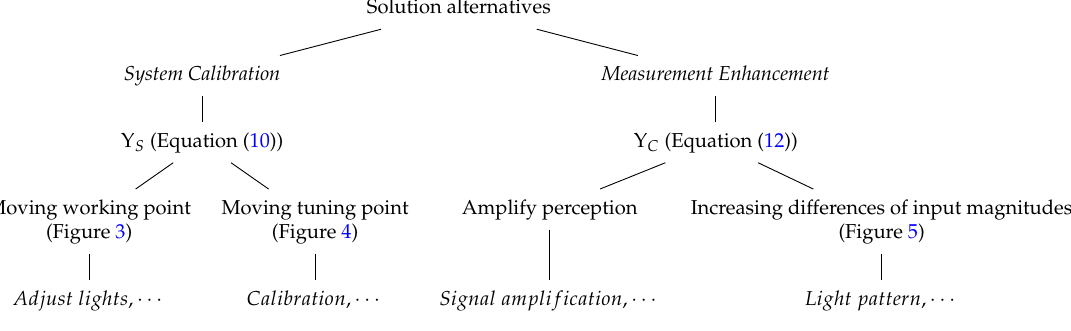
Diagram 2: Diagram with the different alternatives to improve the system perception.